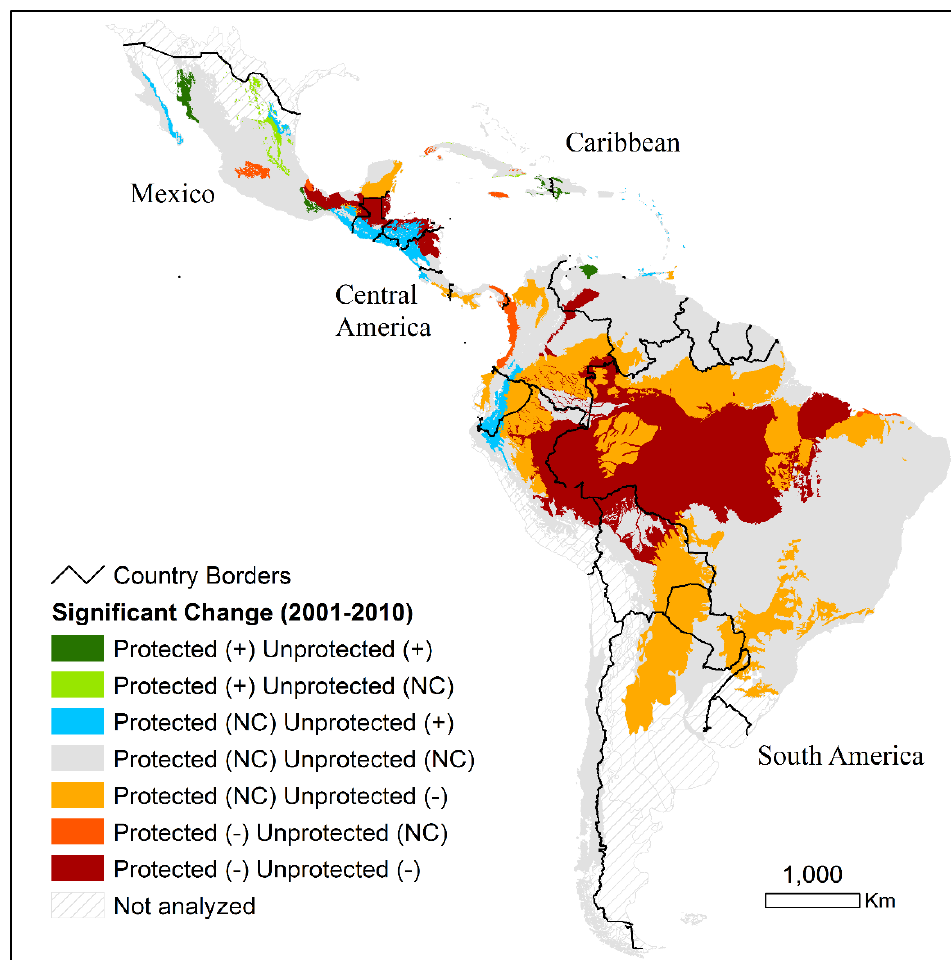
Figure 10. Ecoregions with significant ( p ≤ 0.10) gain (+) or loss ( − ) of woody vegetation from 2001 to 2010 in their protected and unprotected areas (NC = no significant change; Ecoregions or biomes with <10% total woody cover in the year 2010 were not analyzed).